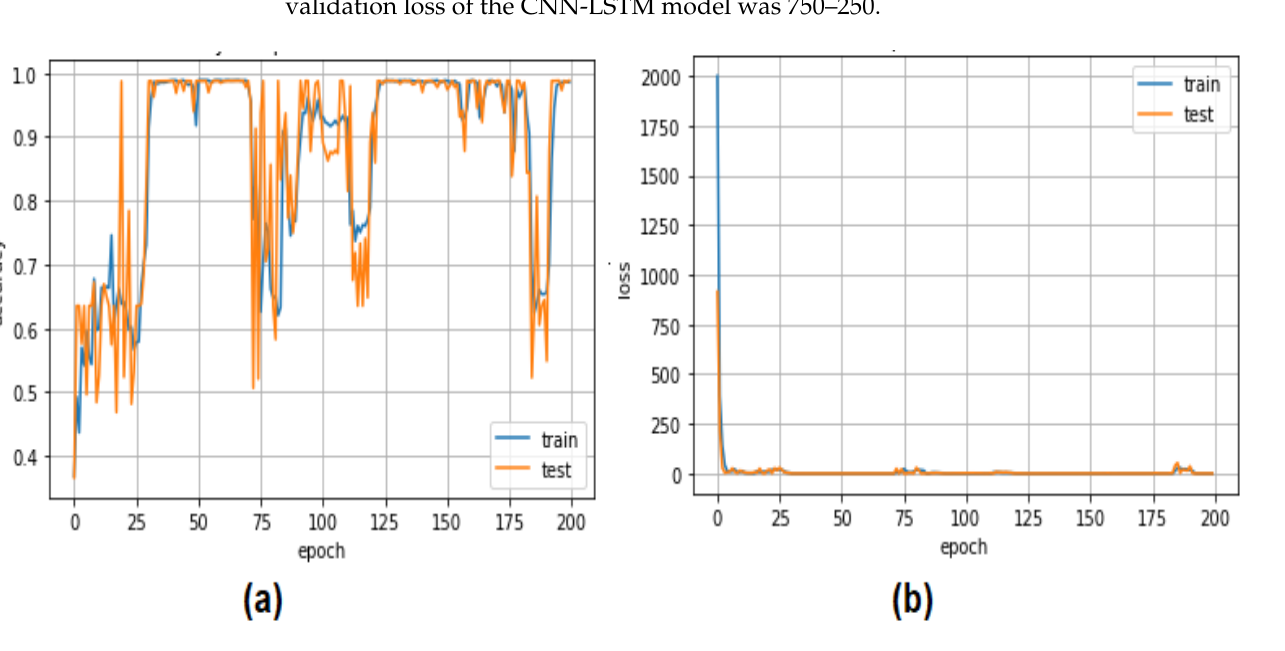
Figure 9. Confusion metrics of the CNN-LSTM model using the binary dataset.